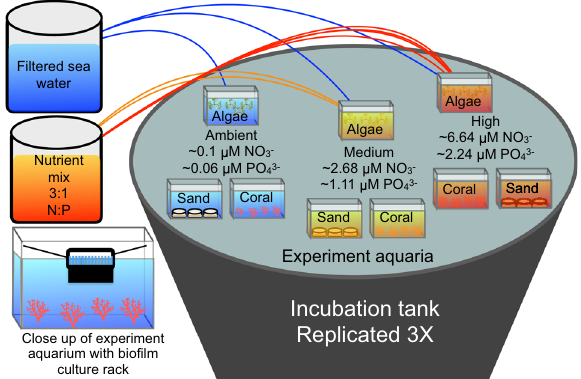
Fig. 1 Experimental design. Three 1300 L fl ow-through incubation tanks were used to maintain constant temperature for nine fl ow- through aquaria each (total 27 experimental aquaria, 6 L volume each); a schematic of one tank with nine aquaria is shown here. Each aquarium held one of three benthic constituent organisms (algae, coral, or sand) and was supplied via peristaltic pump with fi ltered seawater amended to one of three nutrient treatments (ambient, low, or high) from independent header mixing aquaria (one for each nutrient level in each tank to maintain independence). Bio fi lms were cultured on glass slides, evenly spaced in slide racks and suspended vertically in each experimental aquarium to allow water to fl ow around each surface of the slide. Nutrients were measured weekly and were stable throughout the experiment; averages are reported. Additional data in Quinlan et al. 17 and Silbiger et al. 32